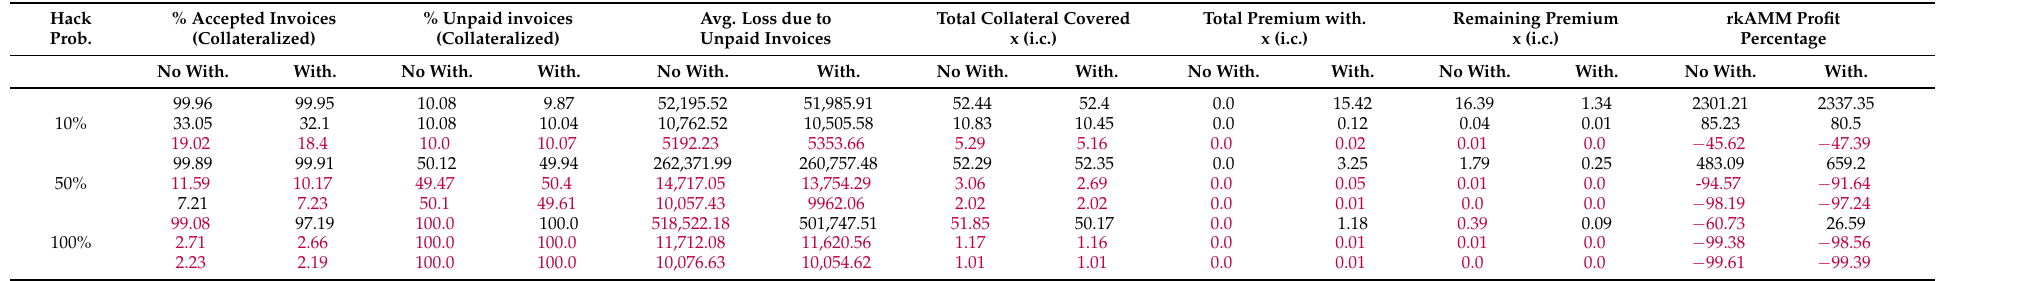
Table 14. rkAMM hack scenario results. Every 90 days, 50% of the premium obtained is